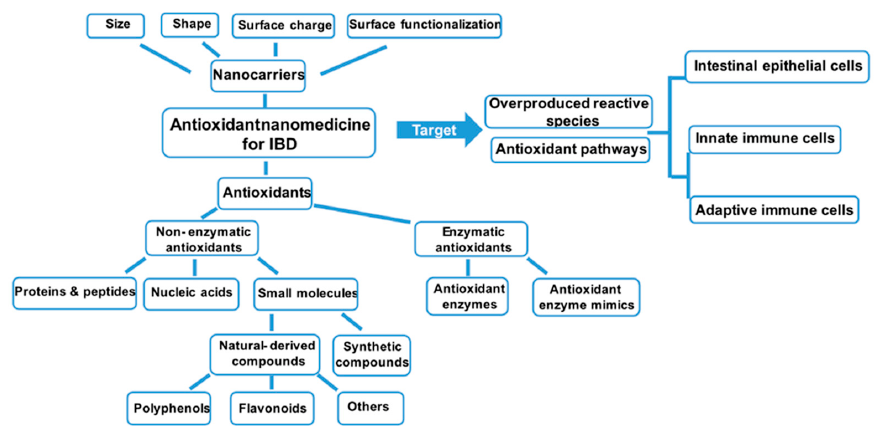
Figure 3. Multiple antioxidant nanomedicines are designed to scavenge the overproduced reactive species (non-enzymatic antioxidants) or enhance the catalyzation of antioxidant processes (enzymatic antioxidants), leading to attenuate the inflammation within the gut. In order to specifically target the inflammatory site (intestinal epithelial cells or the intestinal immune system), the size, shape, surface charge, and surface functionalization should be taken into consideration. The classification of the generally-used antioxidants to treat IBD has been summarized. IBD—inflammatory bowel disease. Table 1. Examples of new innovative antioxidant nanotherapeutic approaches against IBD within the last 5 years.